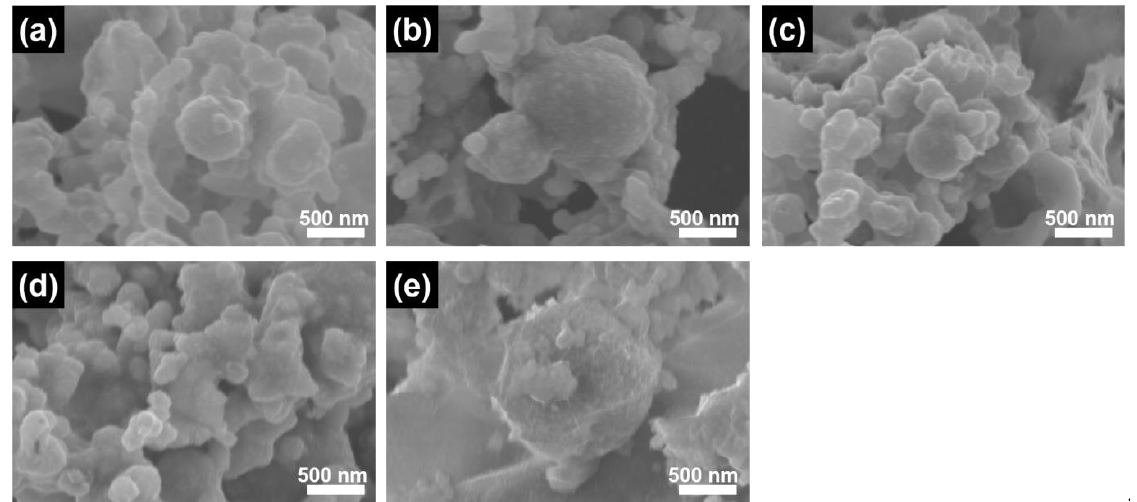
Figure 2. SEM images of Ni nanoparticles synthesized at 100 °C with different concentration ratios of Ni:AB: ( a ) 1:0.1, ( b ) 1:0.2, ( c ) 1:1, ( d ) 1:2, and ( e ) 1:4, respectively.